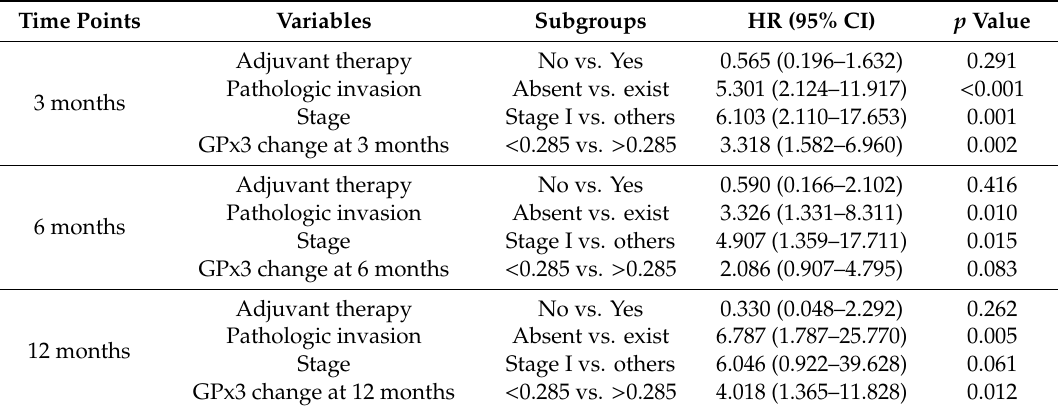
Table 4. Multivariate Cox regression for mean GPx3 change e ff ect on